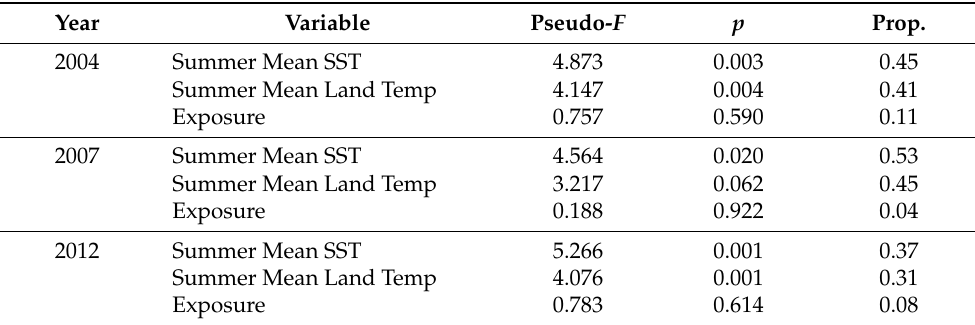
Table 6. Marginal test results of distance-based linear modelling of species similarity with tempera- tures and exposure for survey years. Results show the proportion of variability (Prop.) explained for each variable and its level of significance.